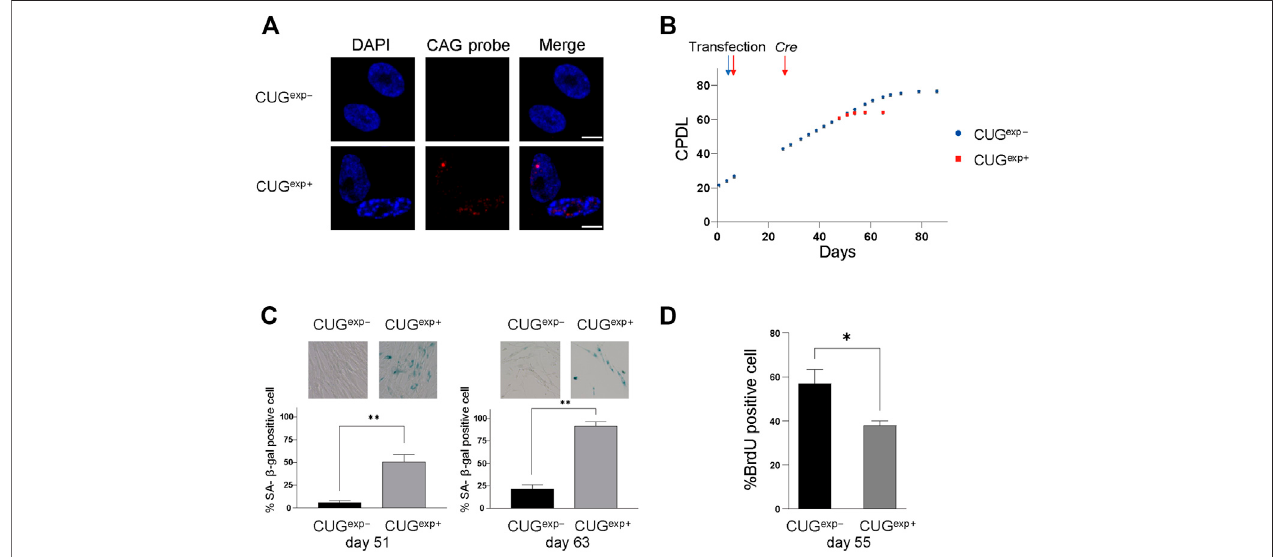
FIGURE 1 | Expanded CUG repeat RNA induces cellular senescence in DM1 model cells. (A) Representative images of RNA FISH analysis in cells not expressing CUG exp (CUG exp − ) and cells expressing CUG exp (CUG exp+ ) at day 53. Nuclear CUG exp foci were present in CUG exp+ cells. Scale bar: 10 μ m. DAPI: 4 ′ ,6-diamidino-2- phenylindole. (B) Cumulative population doubling levels (CPDL) ofCUG exp − cells (blue) and CUG exp+ cells (red) during continuous passages. Cells were transfected with plasmid pLC16 containing 800 CTG repeats at day 6. CUG exp RNA was induced by Cre recombinase at day 25 in CUG exp − cells. Data are presented as means ± SD of three independent experiments. (C) Senescence-associated β -galactosidase (SA- β -gal) activity in CUG exp − and CUG exp+ cells at day 51 (left) and day 63 (right). Representative images of SA- β -gal staining (top). Bar graph shows the percentage of SA- β -gal-positive cells (bottom). Data are presented as means ± SD of three independentexperiments.** p < 0.001. (D) Immunohistochemicalquanti fi cationofthepercentageofBrdU-positivecellsatday55.Dataarepresentedasmeans±SDof three independent experiments. * p <